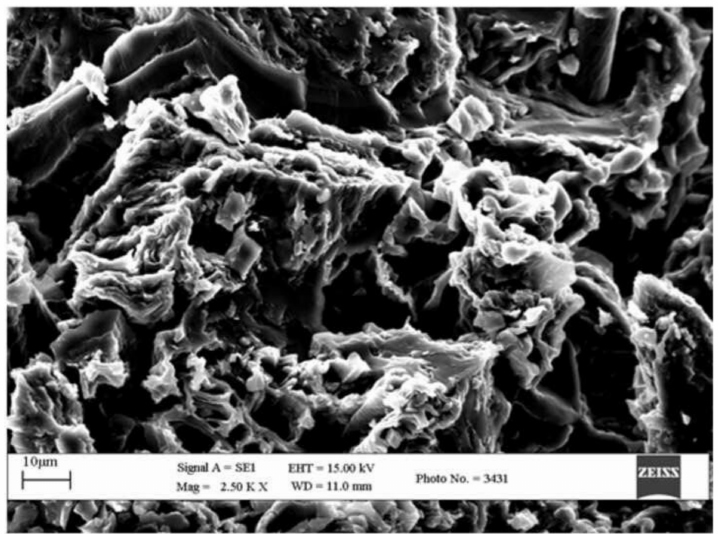
Figure 6. SEM image of modified wheat husk [13].